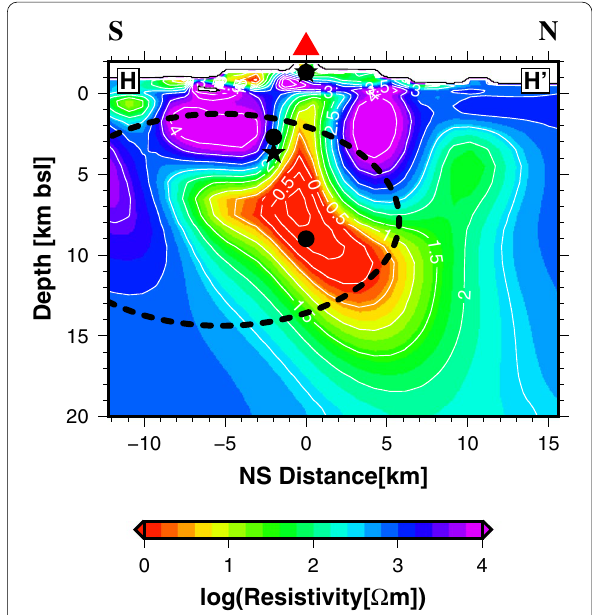
Fig. 18 Low viscosity ellipse model (enclosed by broken line) by Takada and Fukushima (2013), and Mogi source locations of the two (solid circle) or three (solid star) inflation source models by Seki et al. (submitted to Quart. J. Seismology) superimposed on the N–S vertical profile of the final resistivity model ( H ’– H profile in Fig.